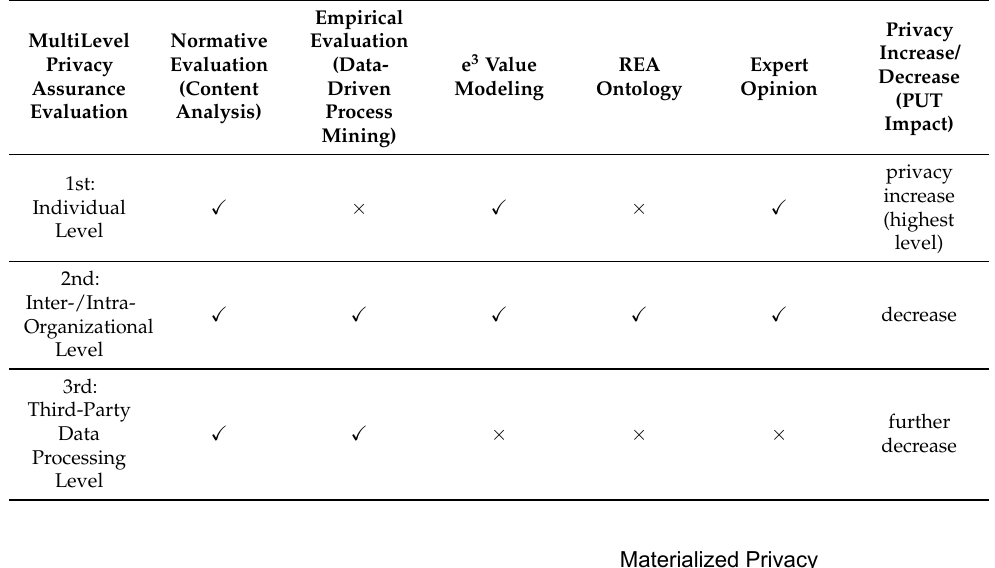
Table 5. Multilevel privacy assurance evaluation: using empirical and normative evaluation of fundamental privacy preserving measures for healthcare metadata handling.